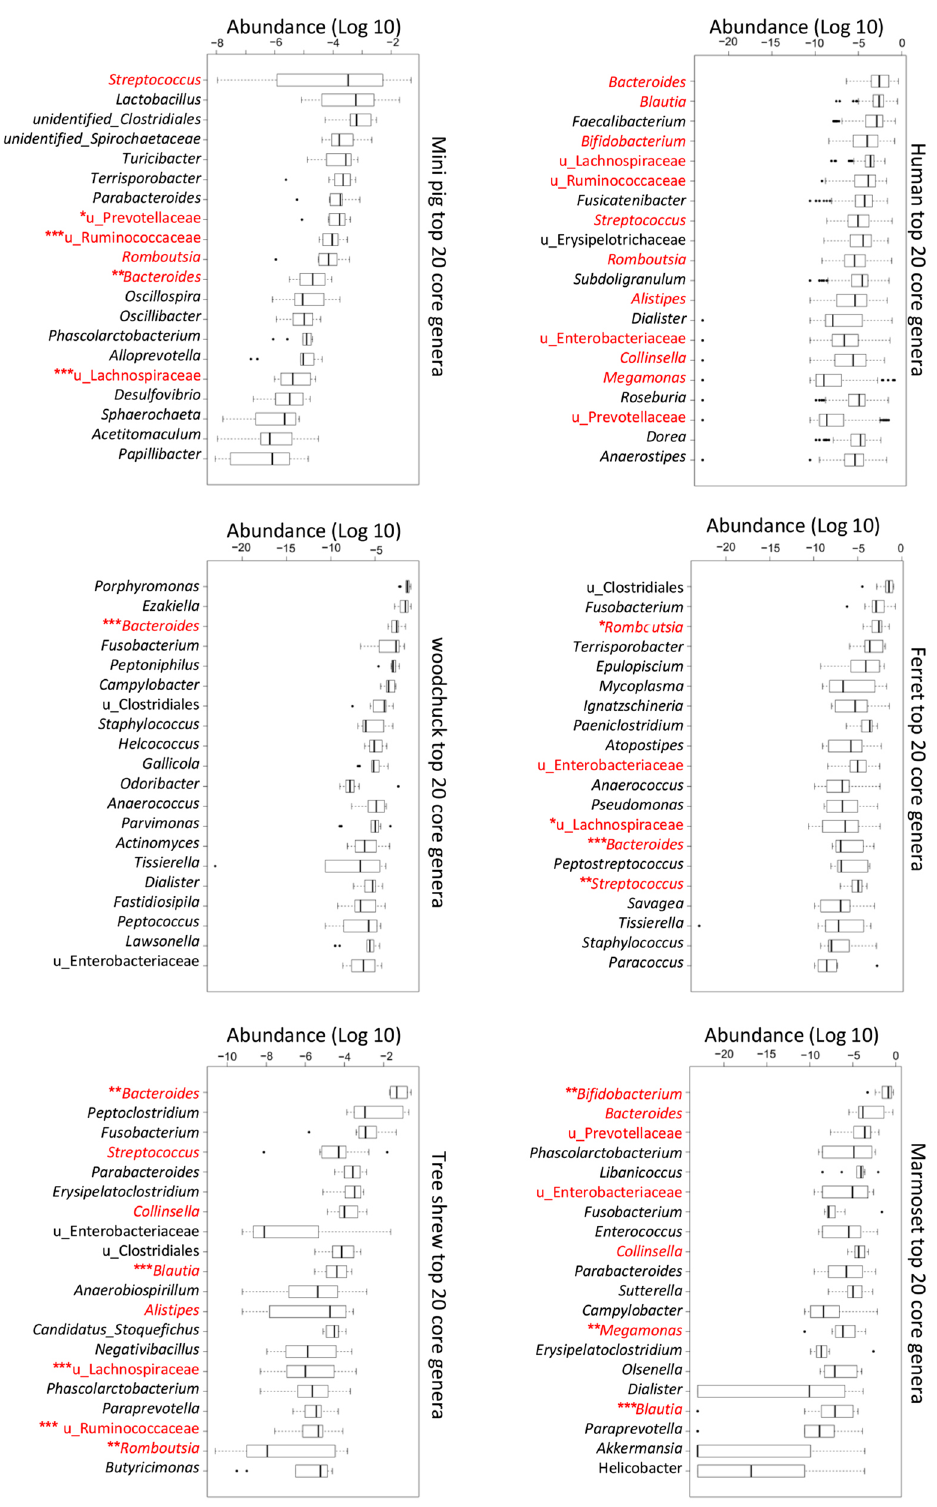
Figure 2. The core genera in the gut microbiota of human and five animal species. Comparison of the core genera in the gut microbiota. The top 20 genera of frequency in the gut microbiota of human and the five animal species are listed with their abundance (Log 10). Those shared genera between human and animal species are marked in red. The shared genera with significantly different abundances between human and animal species are indicated with one asterisk ( *, Wilcox p-value < 0.05), two asterisks ( **, Wilcox p-value < 0.01) or three asterisks ( ***, Wilcox p-value <